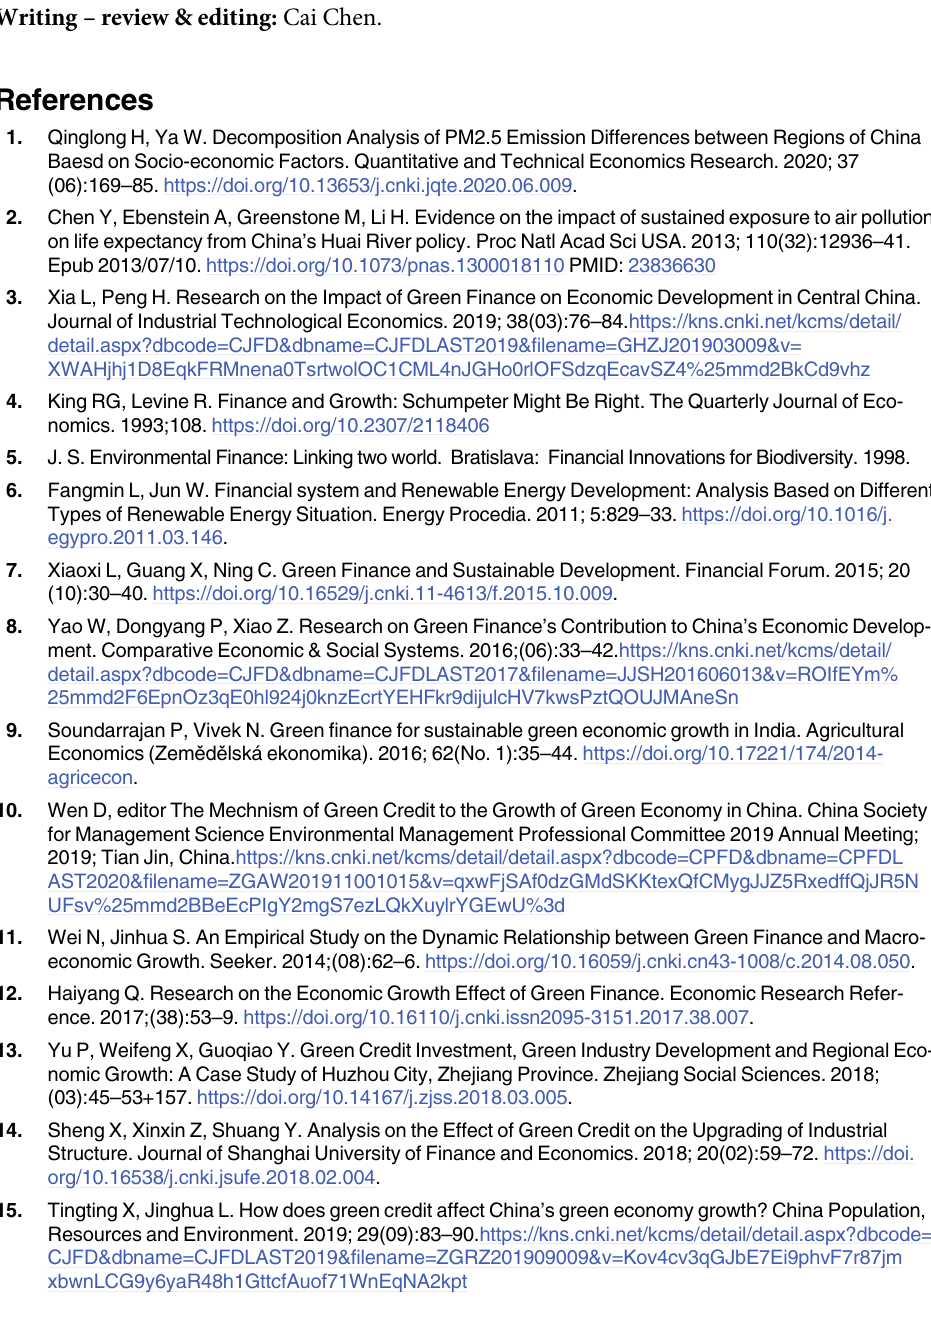
S2 Table. For the calculation of green credit